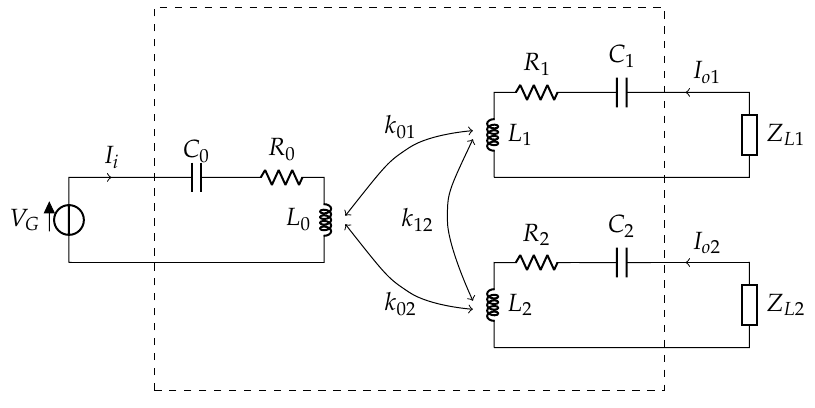
Figure 6. Equivalent circuit analyzed for Case